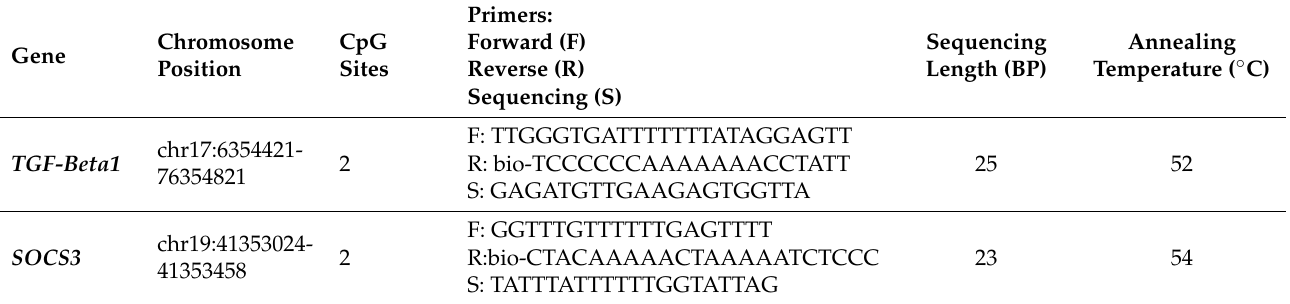
Table 1. Pyrosequencing assays